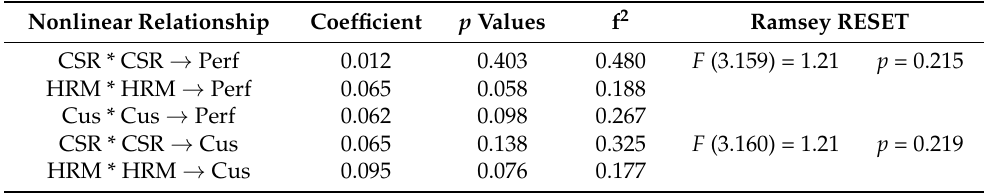
Table 8. Nonlinear